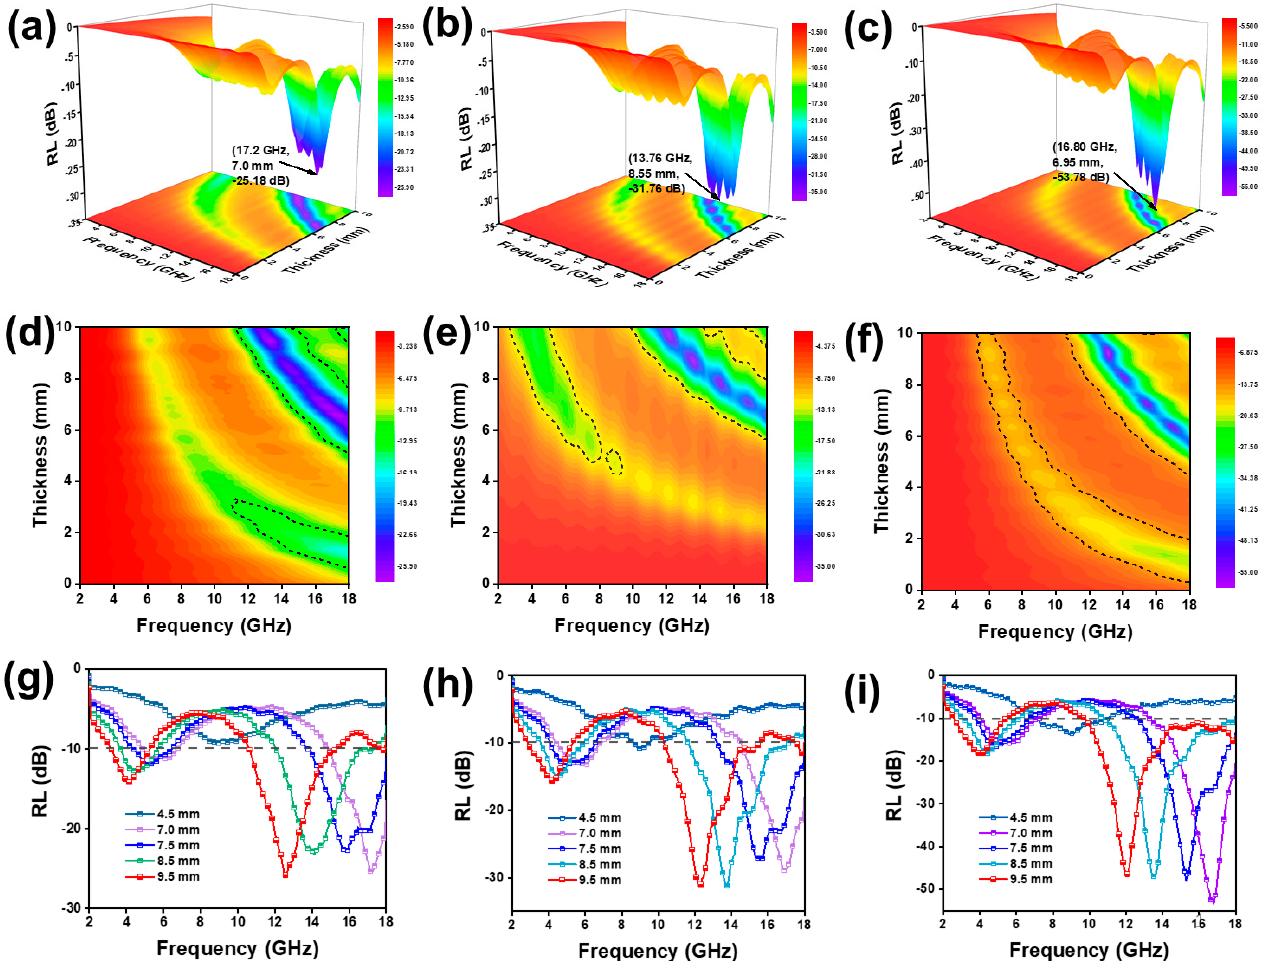
Figure 4. Corresponding 3D plots ( a – c ), 2D plots ( d – f ) with effective absorption bandwidth, and frequency dependence of RL values at different thickness: ( g – i ) SiO 2 @NiFe LDH-1, SiO 2 @NiFe LDH-2, SiO 2 @NiFe LDH-3, respectively.